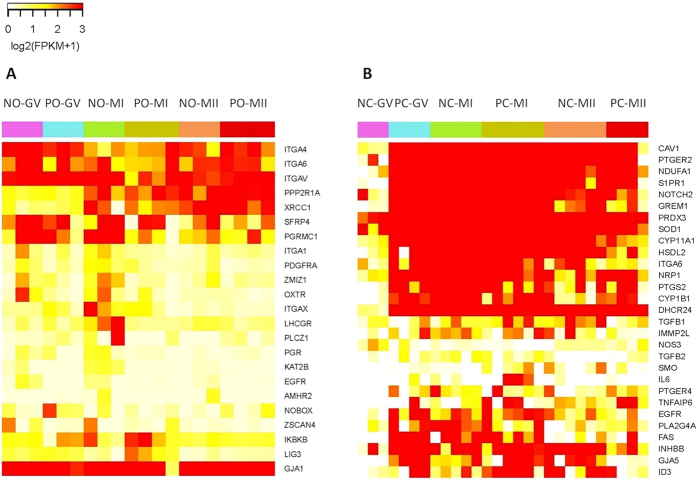
Heatmap of the expression patterns of selected genes at different stages.(A) Heatmap of expression patterns of selected genes in oocyte groups. (B) Heatmap of expression patterns of selected genes in CCs groups.